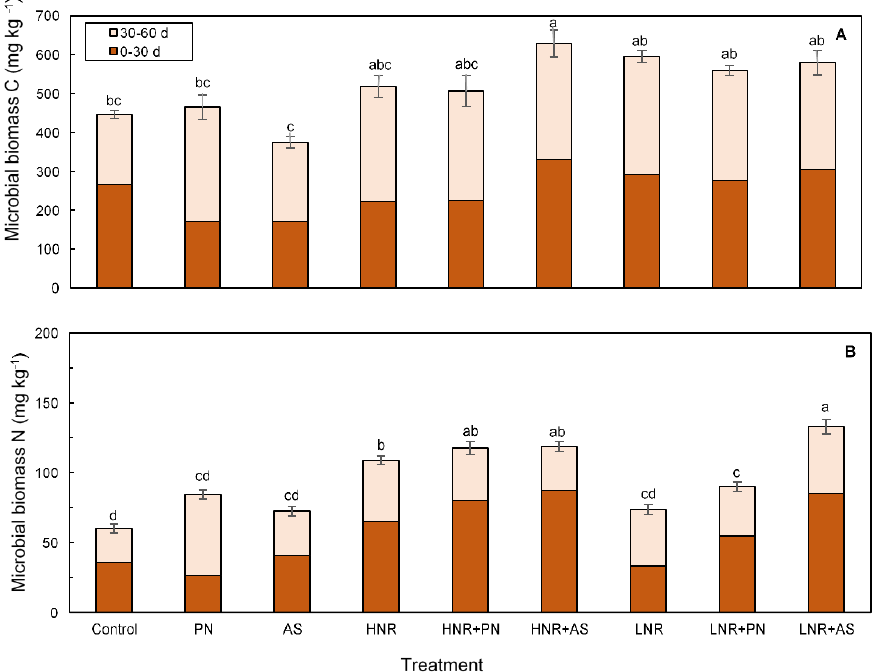
Figure 6. Microbial biomass C ( A ) and microbial biomass N ( B ) measured at five intervals (7, 14, 30, 45, and 60 d) during a 60 d aerobic incubation involving an unamended control and the following eight treatments: potassium nitrate (PN), ammonium sulfate (AS), high N residue (HNR) with or without PN (HNR + PN) or AS (HNR + AS), and low N residue (LNR) with or without PN (LNR + PN) or AS (LNR + AS). Data for each incubation interval shown as a mean from duplicate subsamples with standard error bars. Statistical analyses were performed after averaging data for all five intervals, and treatments do not differ significantly ( p < 0.05) when bars are accompanied by the same letter.